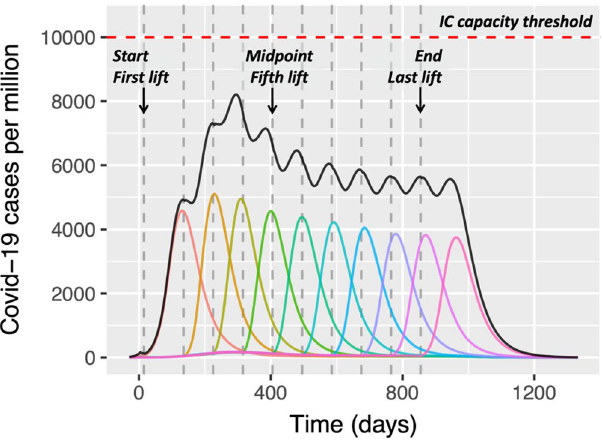
Figure 2. Illustration of a phased lift of